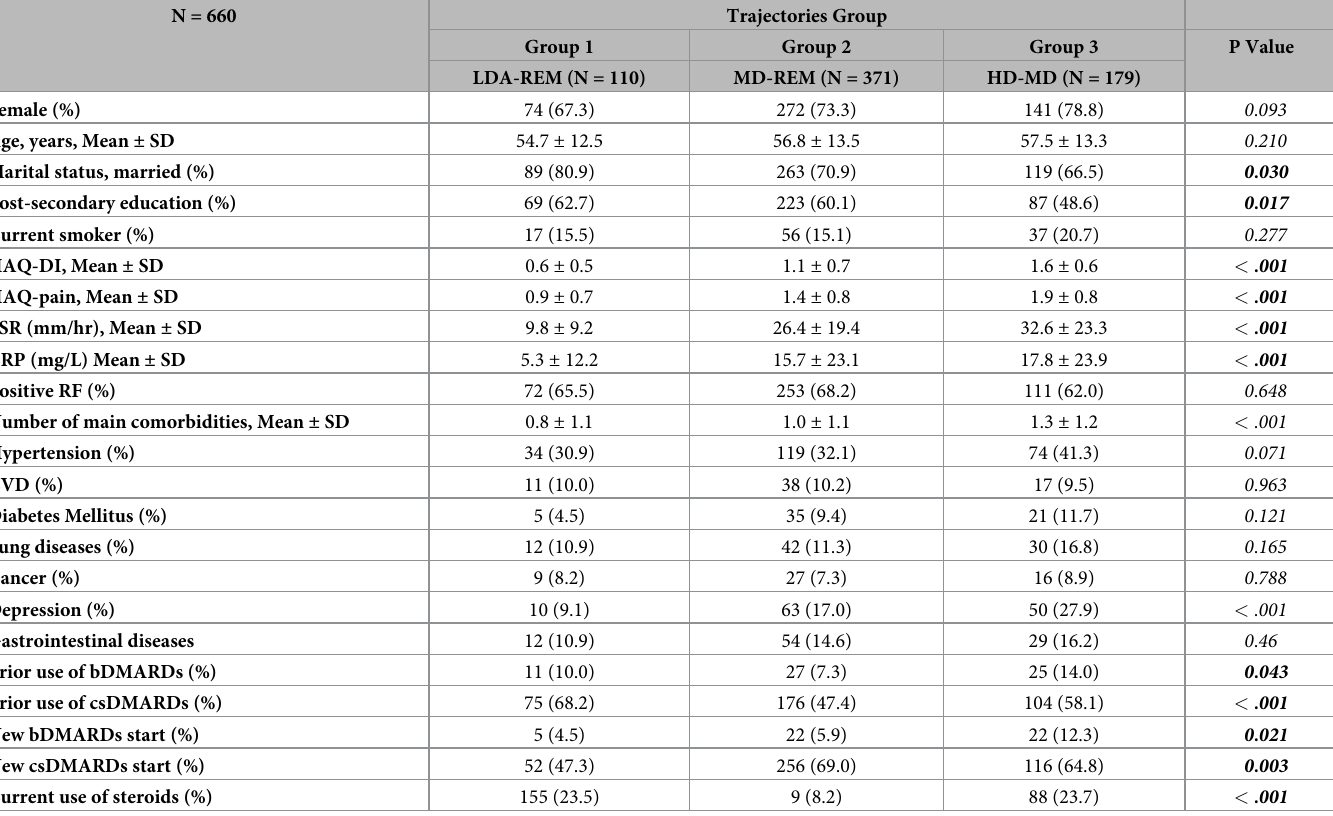
Table 3. Baseline characteristics of patients with early RA across DAS28-ESR trajectory groups. N =